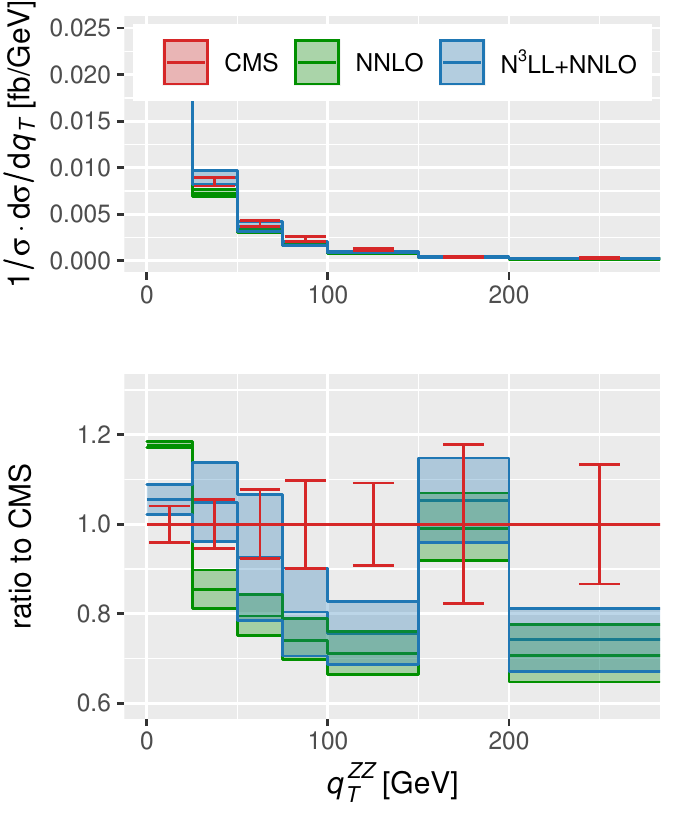
Figure 2 . The q ZZ distribution at NNLO and N 3 LL+NNLO compared to the CMS data from T ref.